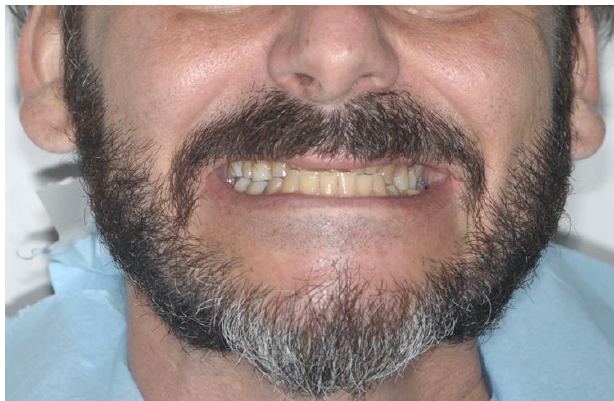
Figure 1. Case 1—Extraoral view of a patient with eating disorders and severe parafunctional habits.